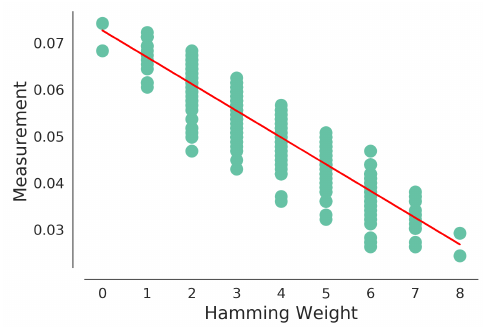
Figure 37: Measured leakages vs. actual Hamming weights on the